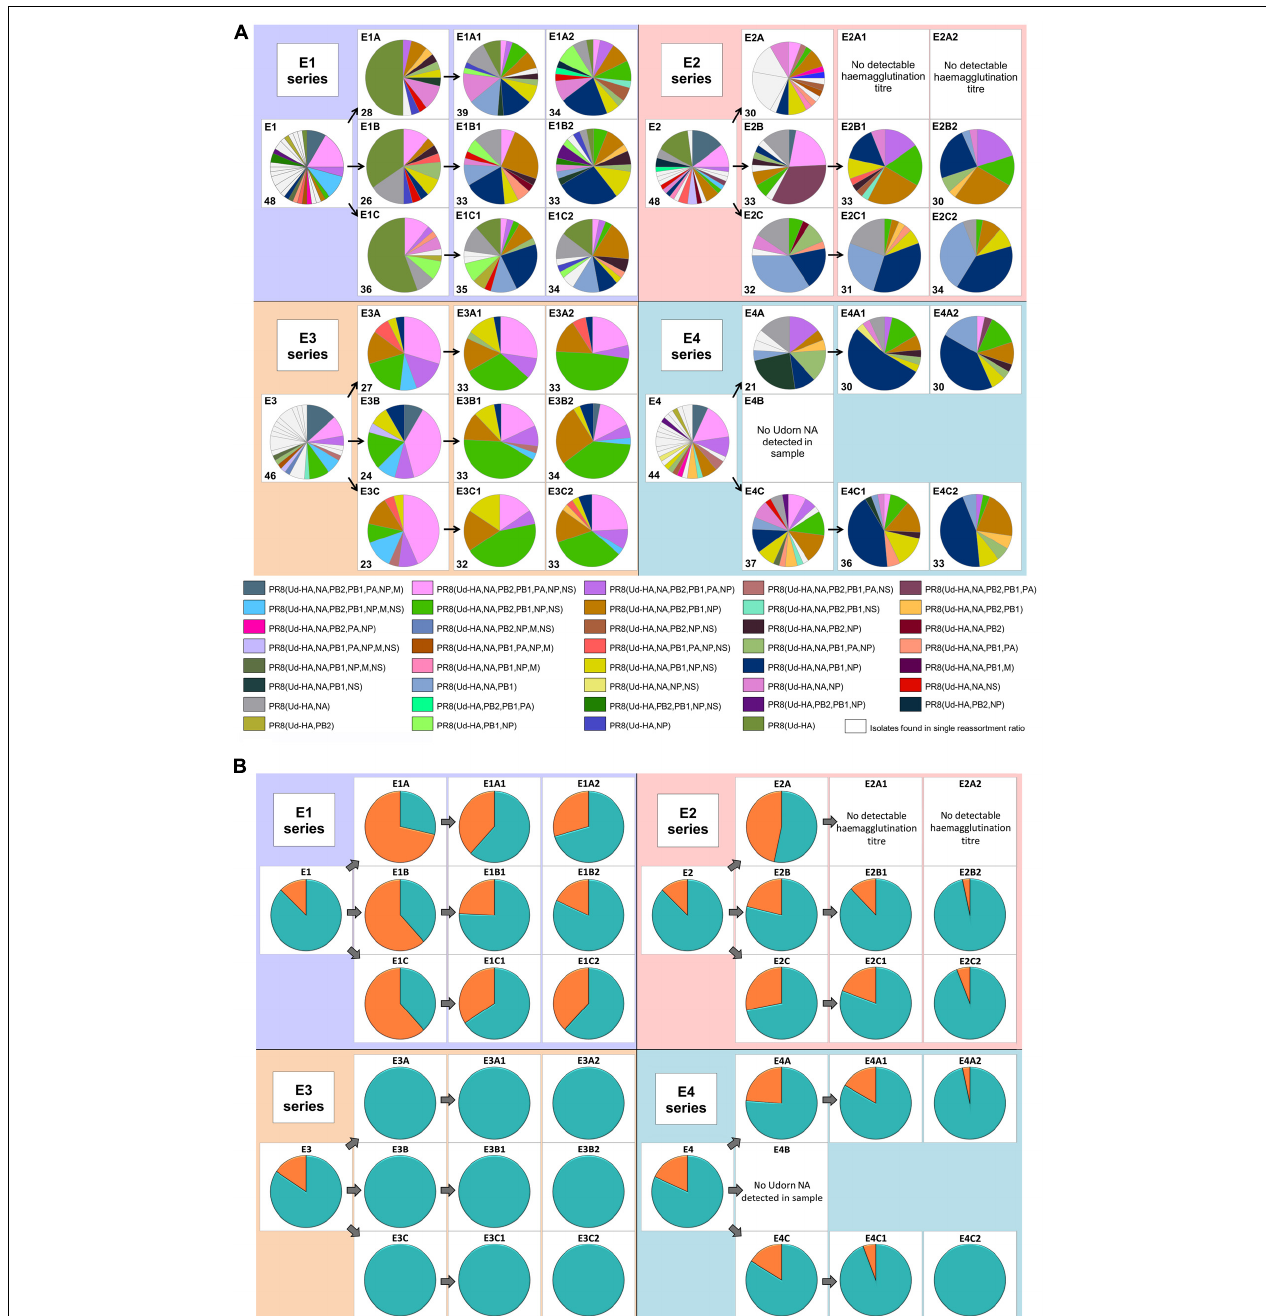
FIGURE 2 | The diversity of reassortant viruses isolated during the reassortment process. Viruses from the allantoic fluid of each egg were isolated by plaque assay. For the co-infected eggs, plaquing was performed in the presence of PR8 antiserum. The genotype of virus in individual plaques was determined using gene specific RT-PCR. Each of the four larger panels represents eggs that originated from the different co-infection ratios ( Figure 1B ). The pie charts represent the viruses isolated in the individual eggs corresponding to the co-infection and antiserum passages ( Figure 1A ). The dominant gene constellations present in the individual eggs are represented according to the colours in the key. The nomenclature used indicates the Udorn genes on the PR8 background, e.g., PR8(Ud-HA) is a virus with the HA gene from Udorn and the remaining seven genes from PR8. White segments represent gene constellations that were only present in that particular egg. No data is available for eggs E2A1 and E2A2 as the allantoic fluids did not have detectable haemagglutination titres and were not examined further. Initial screening of egg E4B showed that Udorn NA was not present so complete genotypes were not analysed. The number of individual plaques analysed for each egg is indicated in the bottom left of each pie chart panel. (B) The frequency of the Udorn PB1 gene (teal) and PR8 PB1 gene (orange) in the genotypes of the individual virus plaques shown in panel (A) .